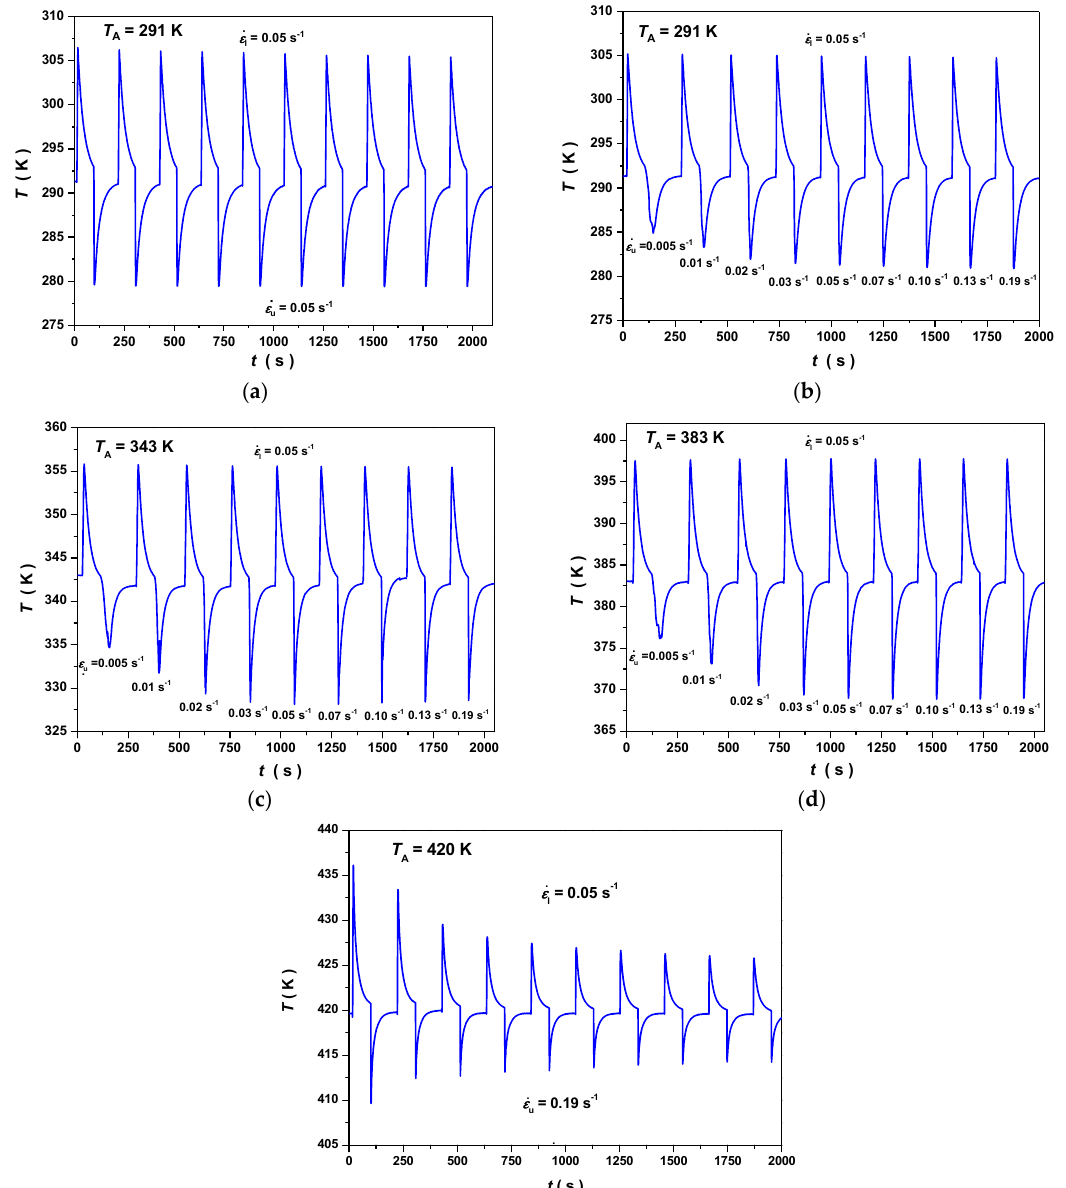
Figure 5. Temperature-time profiles with a specific unloading strain rate: ( a ) ε(cid:4662) u = 0.05 s − 1 , T A = 291 K; ( e ) ε(cid:4662) u = 0.19 s − 1 , T A = 420 K and with various unloading strain rates ( ε(cid:4662) u = 0.005–0.19 s − 1 ) at T A = 291 K ( b ), T A = 343 K ( c ), and T A = 383 K ( d ) for the columnar-grained Cu 71 Al 17.5 Mn 11.5 shape memory alloy (SMA) samples ( ε(cid:4662) l = 0.05 s − 1 for all samples).